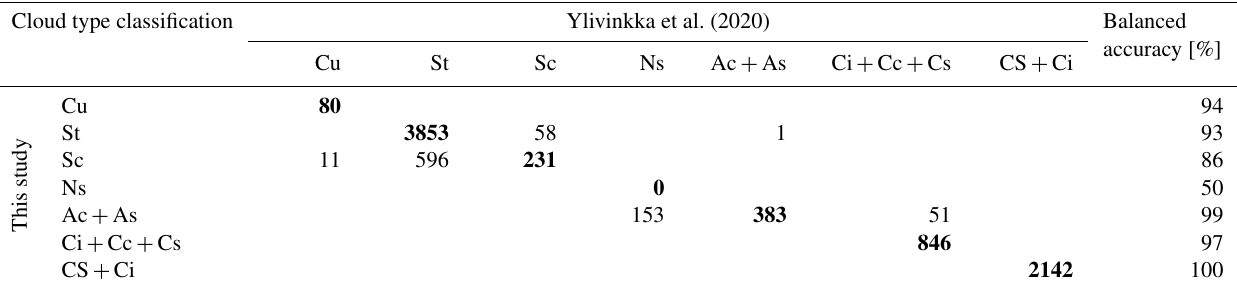
Table B4. Confusion matrix and balanced accuracy for each cloud type classified using the algorithm reported in the present study and the one reported in Ylivinkka et al.